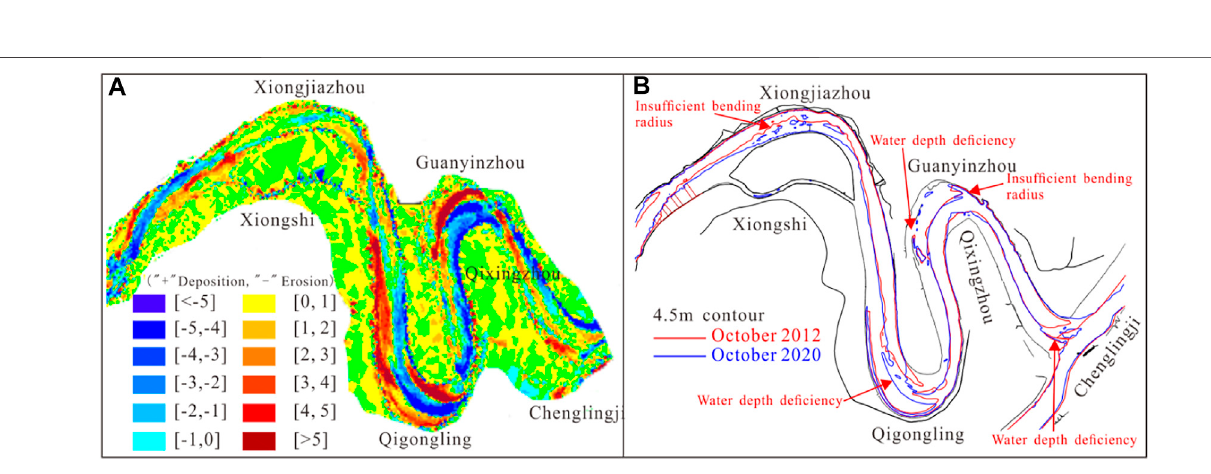
Frontiers in Earth Science |